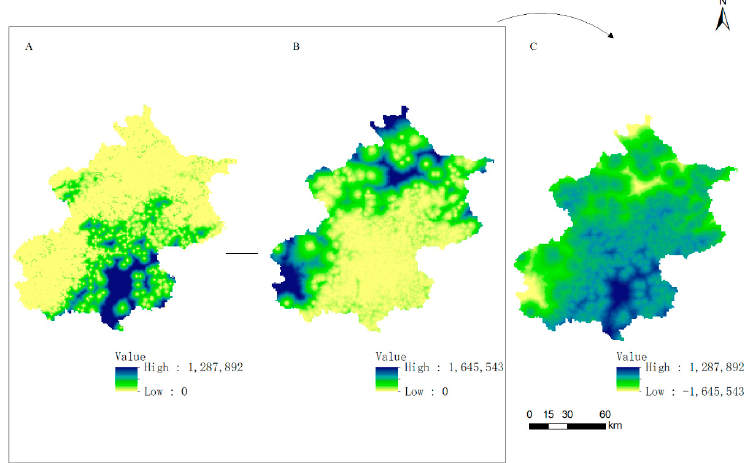
Figure 5. Minimal cumulative resistance surface of ecological sources ( A ) and urban sources ( B ) and the difference surface of Beijing city ( A – C ).